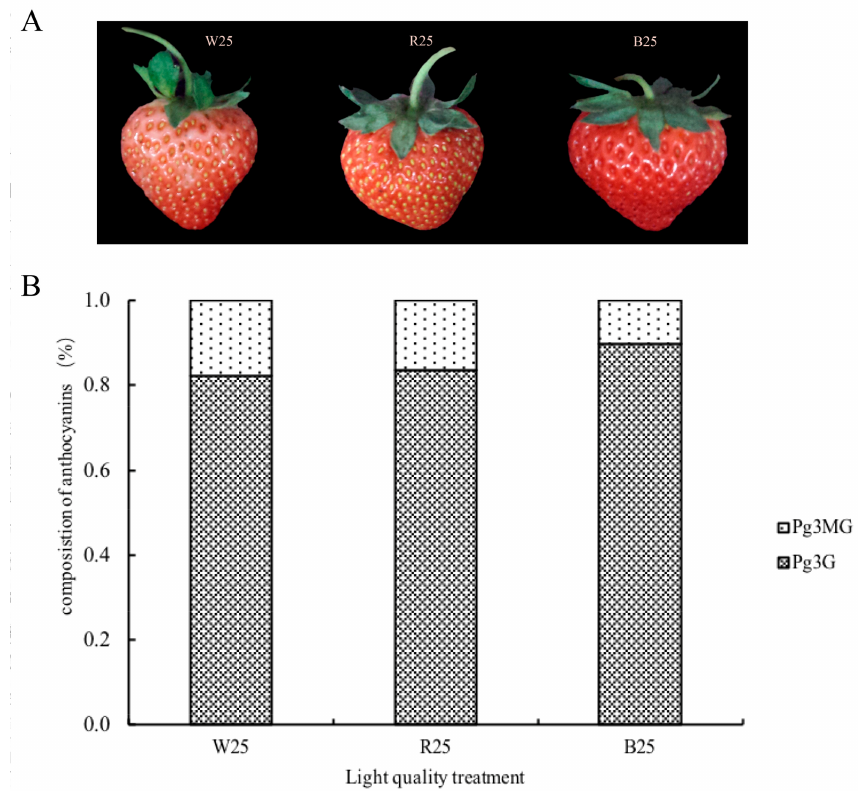
Figure 1. Strawberry phenotypes ( A ) and the composition of anthocyanins ( B ) after white, red, and blue light treatment. W25, R25 and B25 indicate that fruit samples treated by white, red, and blue light were collected on the 25th day after flowering. Pg3G, Pelargonidin 3-glucoside; Pg3MG, pelargonidin